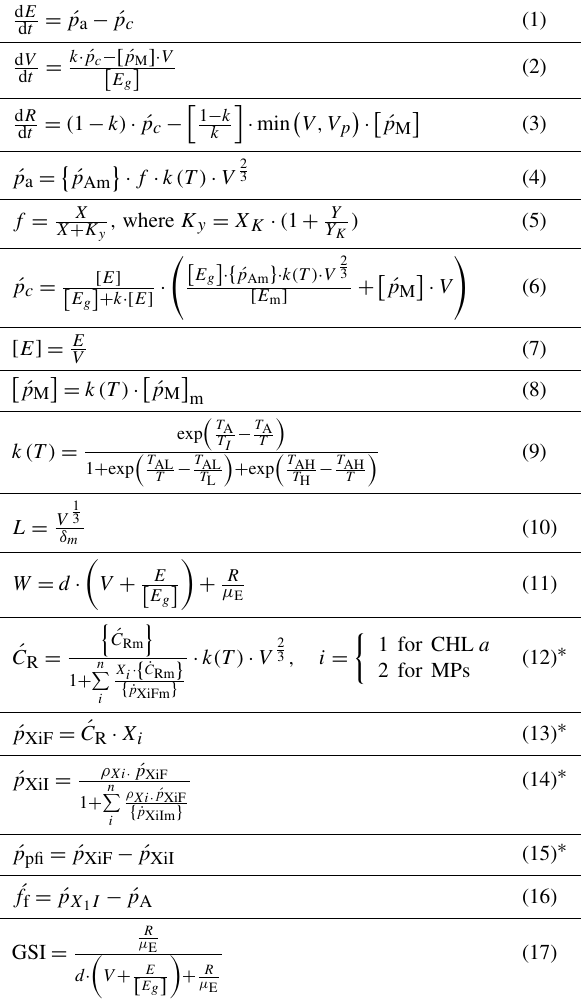
Table 1. Dynamic energy budget model: equations. See Table 2 for model variables, Table 3 for parameters, and Table 5 for initial val-